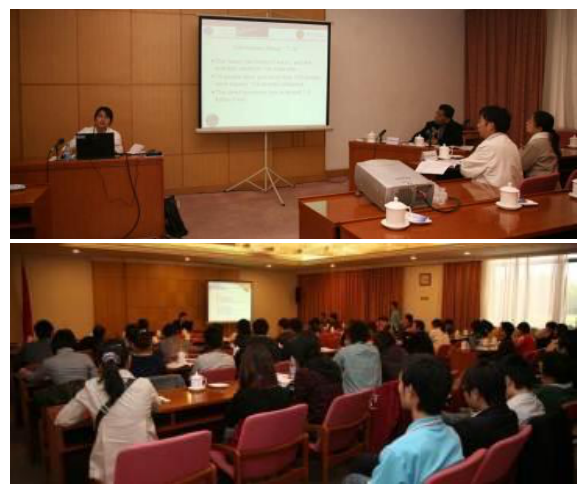
Figure 2. Technical sessions for students at the ACRS